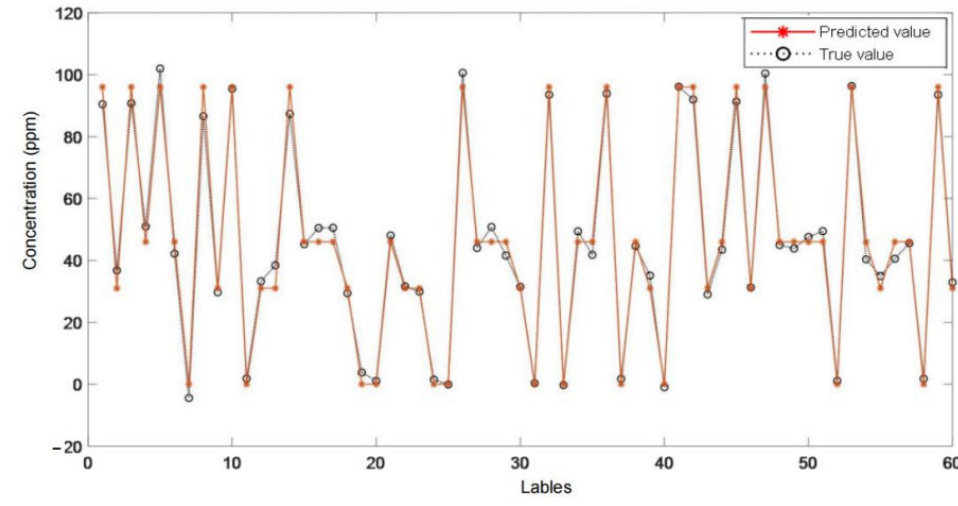
Figure 11. Predicted results of ethylene gas concentration using the PSO-LSSVM method under the condition of a high concentration of carbon monoxide as the background gas.